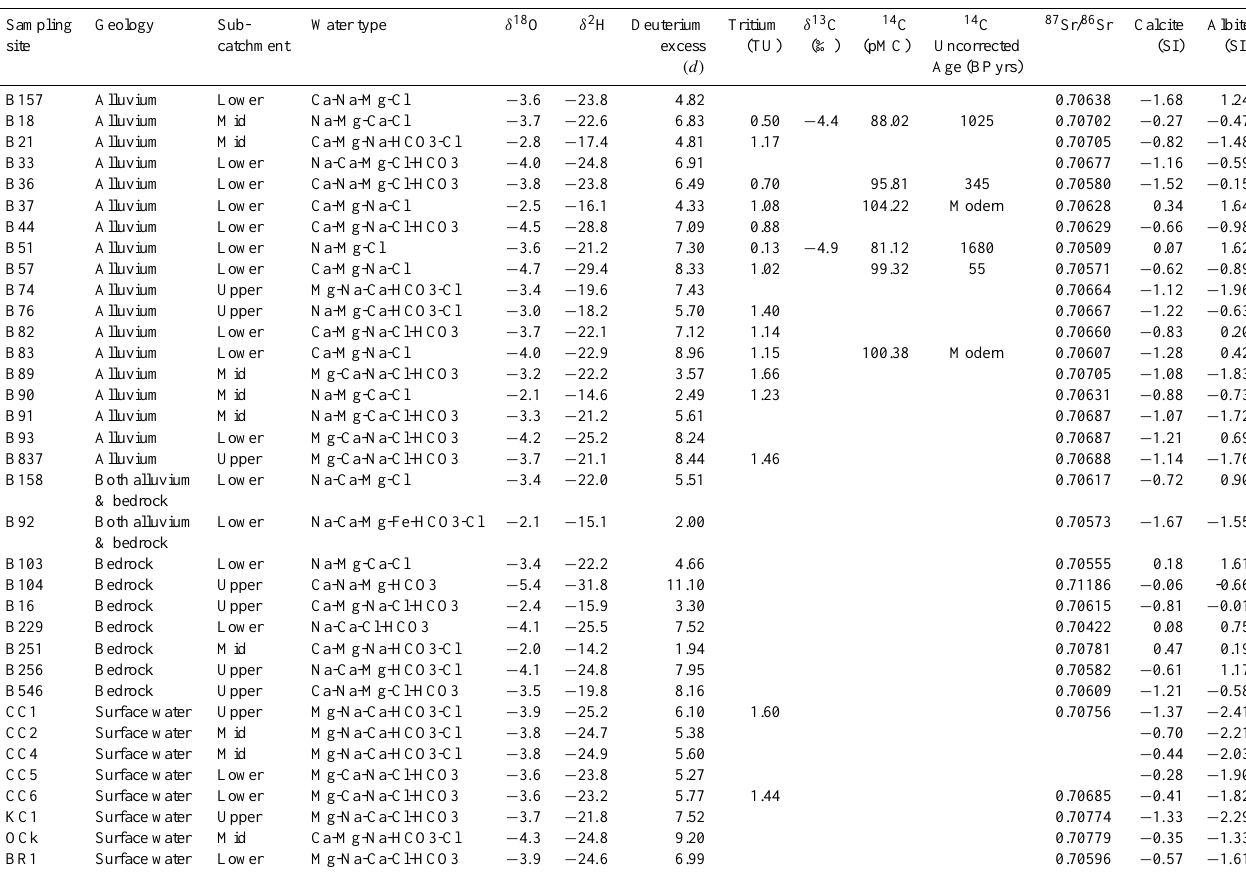
Table 4. Water isotopic and hydrochemical data for surface- and groundwater samples from the Cressbrook Creek catchment. Saturation indices (SI) for calcite and albite were calculated using PHREEQC (Parkhurst and Appelo, 1999). Sampling Geology